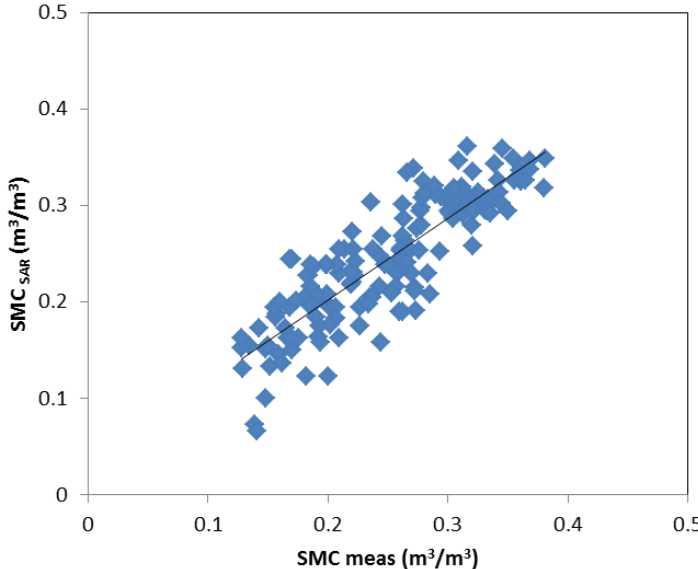
Figure 3. SMC estimated by the algorithms (SMC of the Scrivia area as a function of the SMC measured on ground (SMCmeas, in m 3 /m 3 ). The continuous line represents the regression equation of the